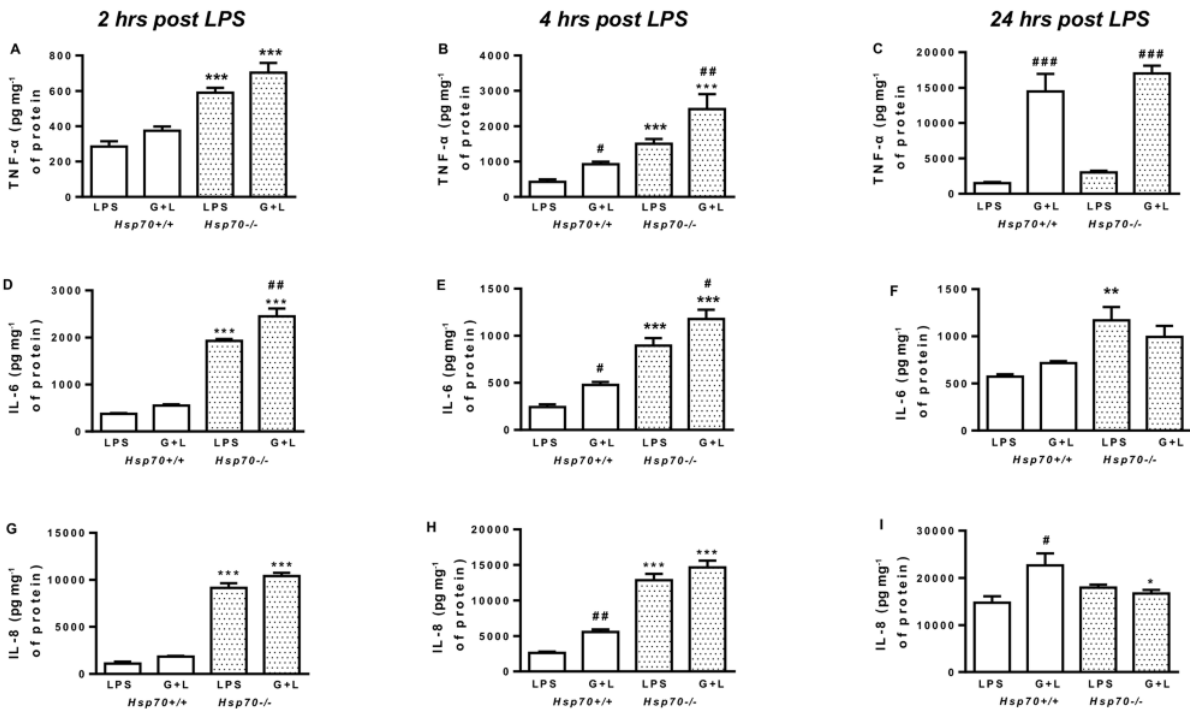
Figure 5. E ff ect of LPS and GLN in primary macrophages of Hsp70+/+ and Hsp70-/- mice. Primary macrophages were treated with 100 ng mL -1 LPS in the presence or absence of 10 mM of GLN. ELISA analysis of TNF- α (A-C), IL-6 (D-F) and IL-8 (G-I) was performed upon stimulation with LPS at 2, 4, and 24 hrs prior to cell harvesting, respectively. Means ± SEM. Asterisks (*) depict statistical di ff erence between genotypes exposed to the same treatment. *, p < 0.05; **, p < 0.001; ***, p < 0.0001. Hash signs (#) depict statistical di ff erence between treatments on the same genotype. #, p < 0.05; ##, p < 0.001; ###, p < 0.0001. Each graph shows a representative experiment of at least three independent